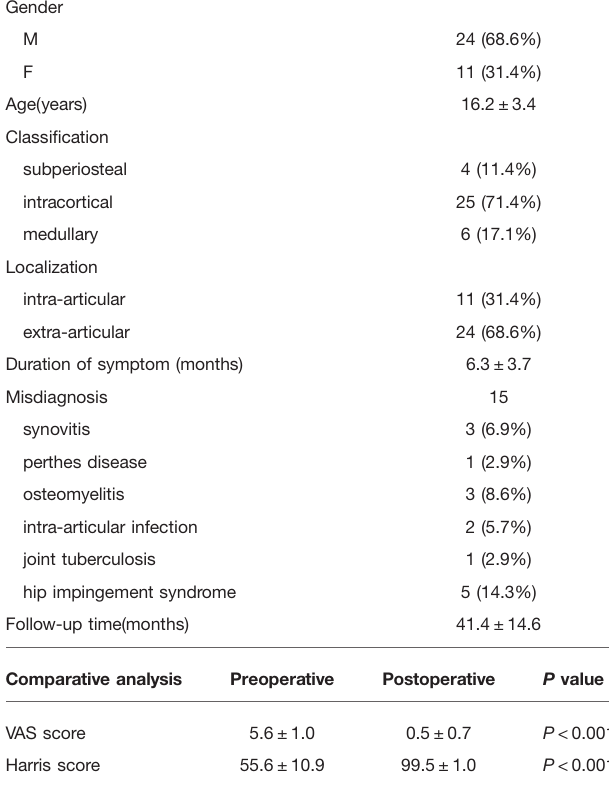
TABLE 1 | Demographic and clinical information of